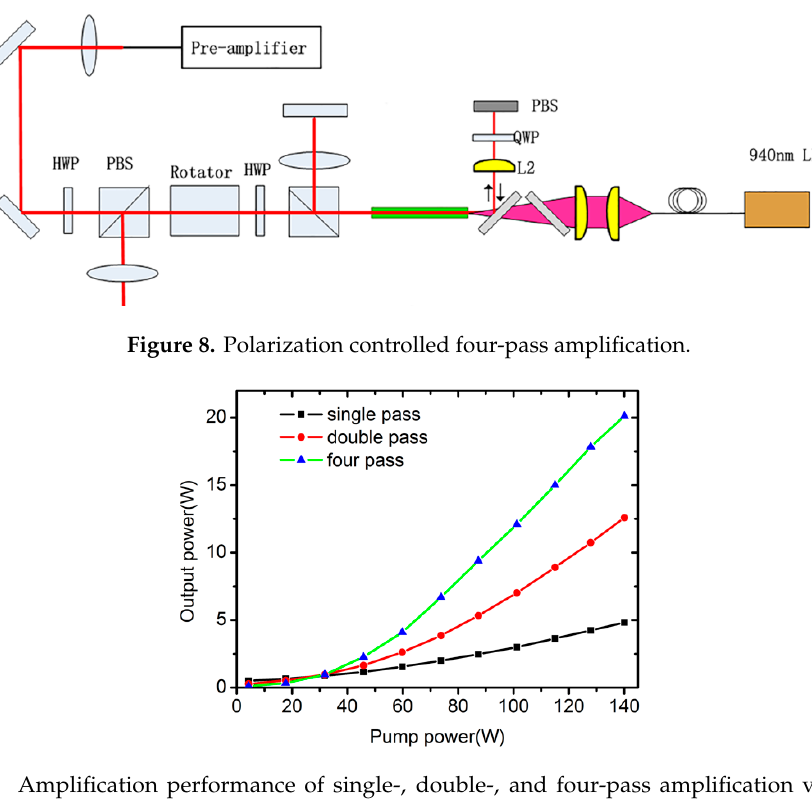
Figure 7. Pulse width measurement of di ff erent amplified power outputs. ( a ) Autocorrelation curves of the preamplifier; ( b ) autocorrelation curves of the first- stage SCF amplifier; ( c ) the second stage SCF amplifier.